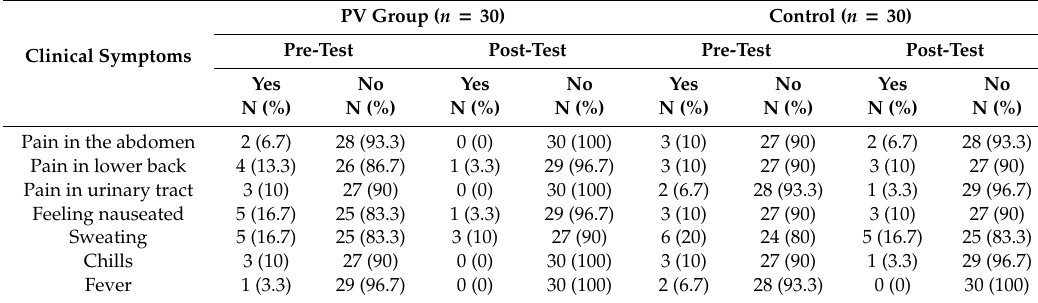
Table 2. Clinical Assessment.